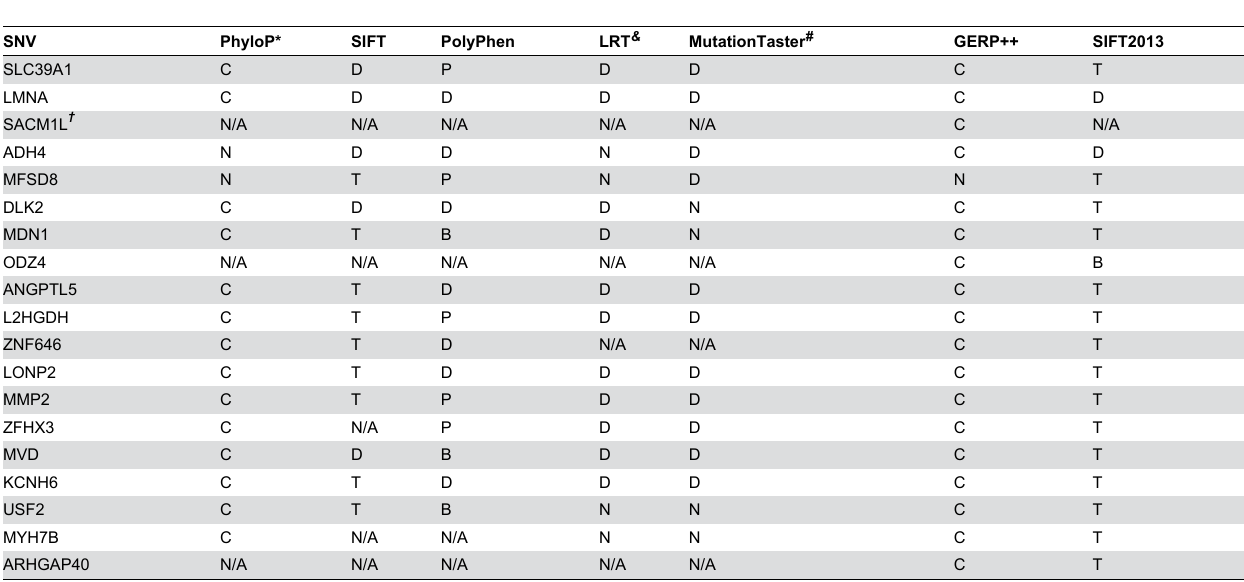
Table 4. Family-specific variants sorted by autosomal dominant inheritance and annotated by ANNOVAR.